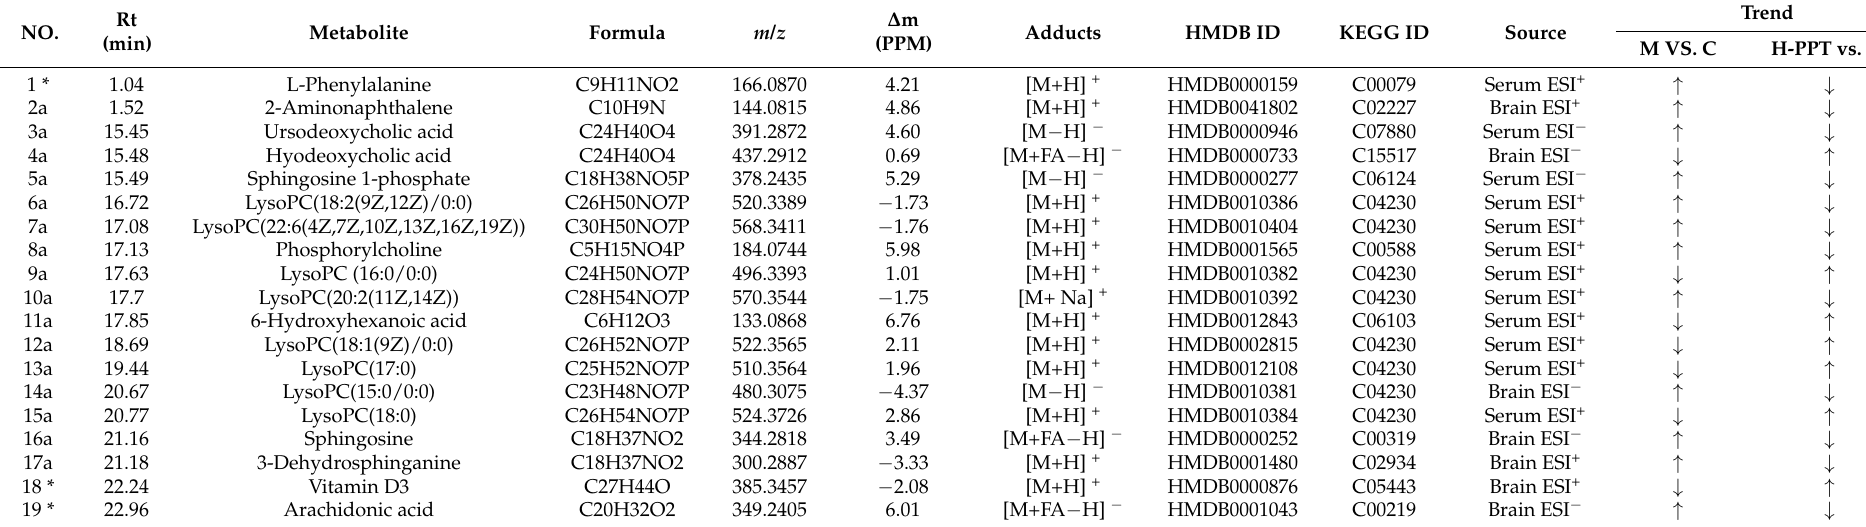
Table 1. The endogenous metabolites identified in serum and brain which can be regulated by